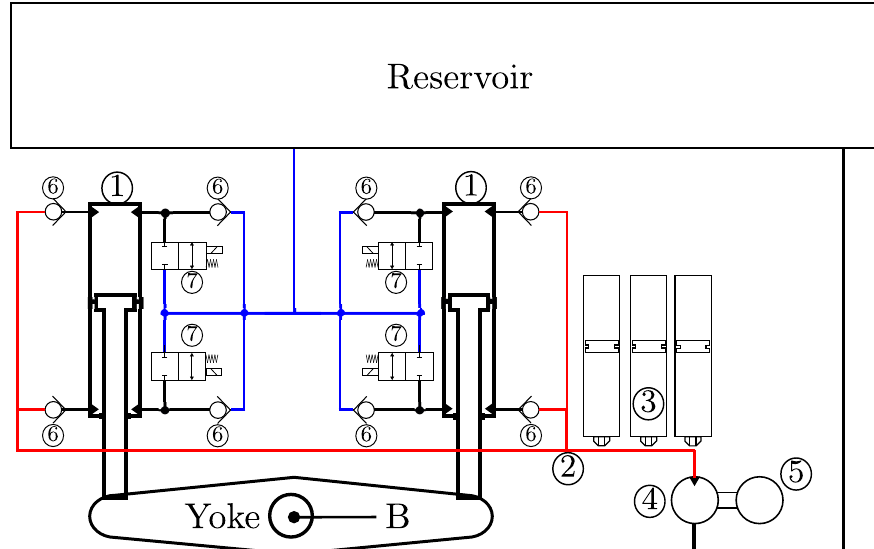
Figure 2. Simple illustration of the power take-off in the PTO housing, note that point B is the same as in Figure 1. Blue and red line colors indicates low and high pressure respectively.